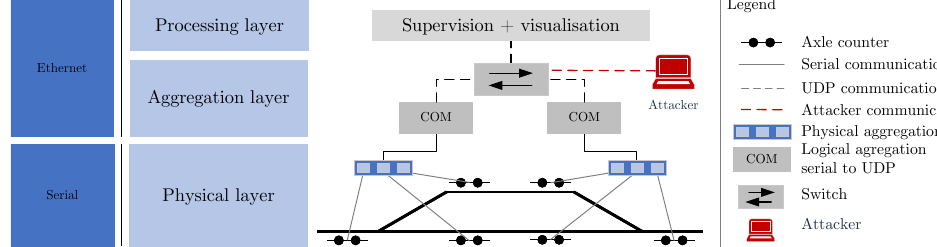
Figure 2. System diagram of the testbed and attack vectors that our proposed method